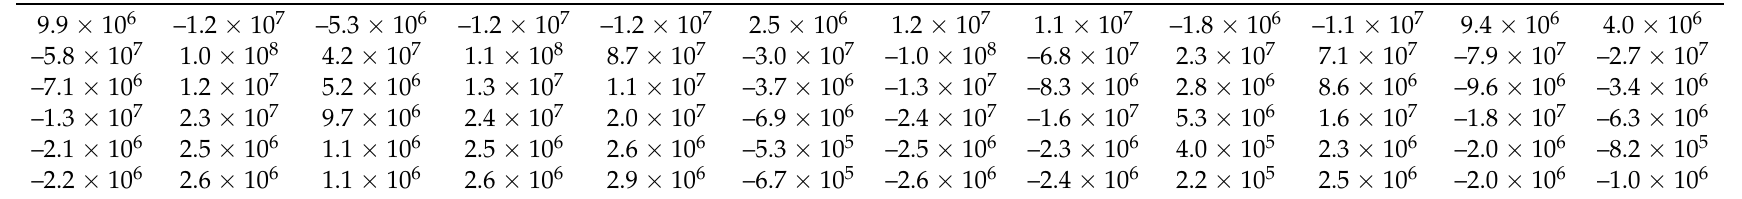
Table 4. Conversion matrices K determined according to Section 7 resulting from an inadequate calibration